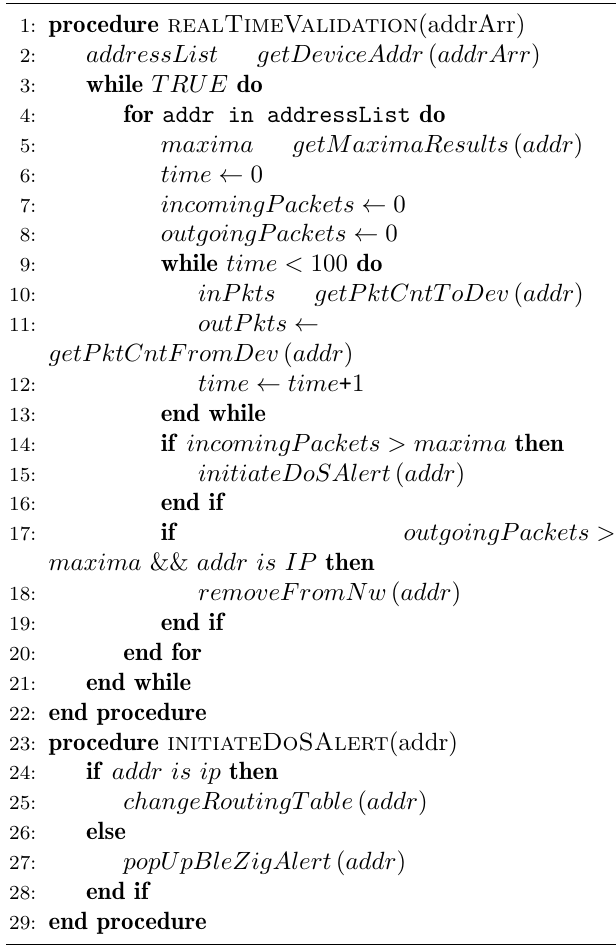
Algorithm 3 OWL